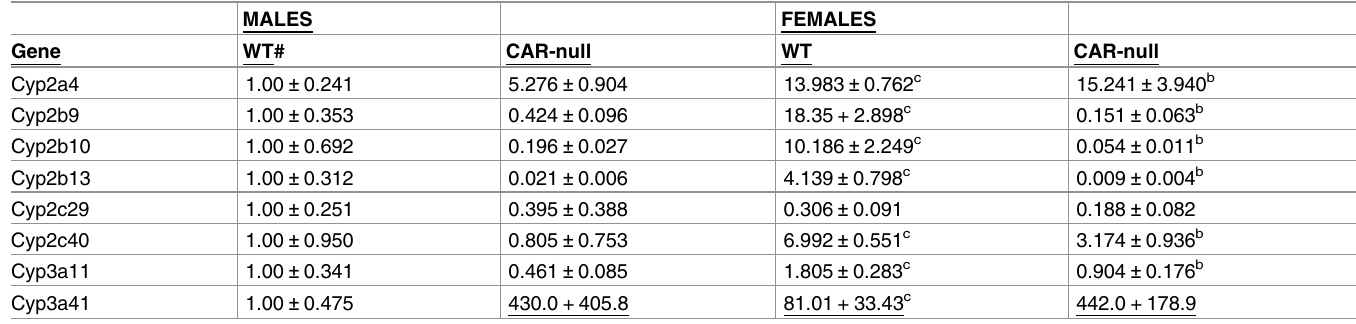
Table 1. Compensatory changes in CYP gene expression in CAR-null mice.